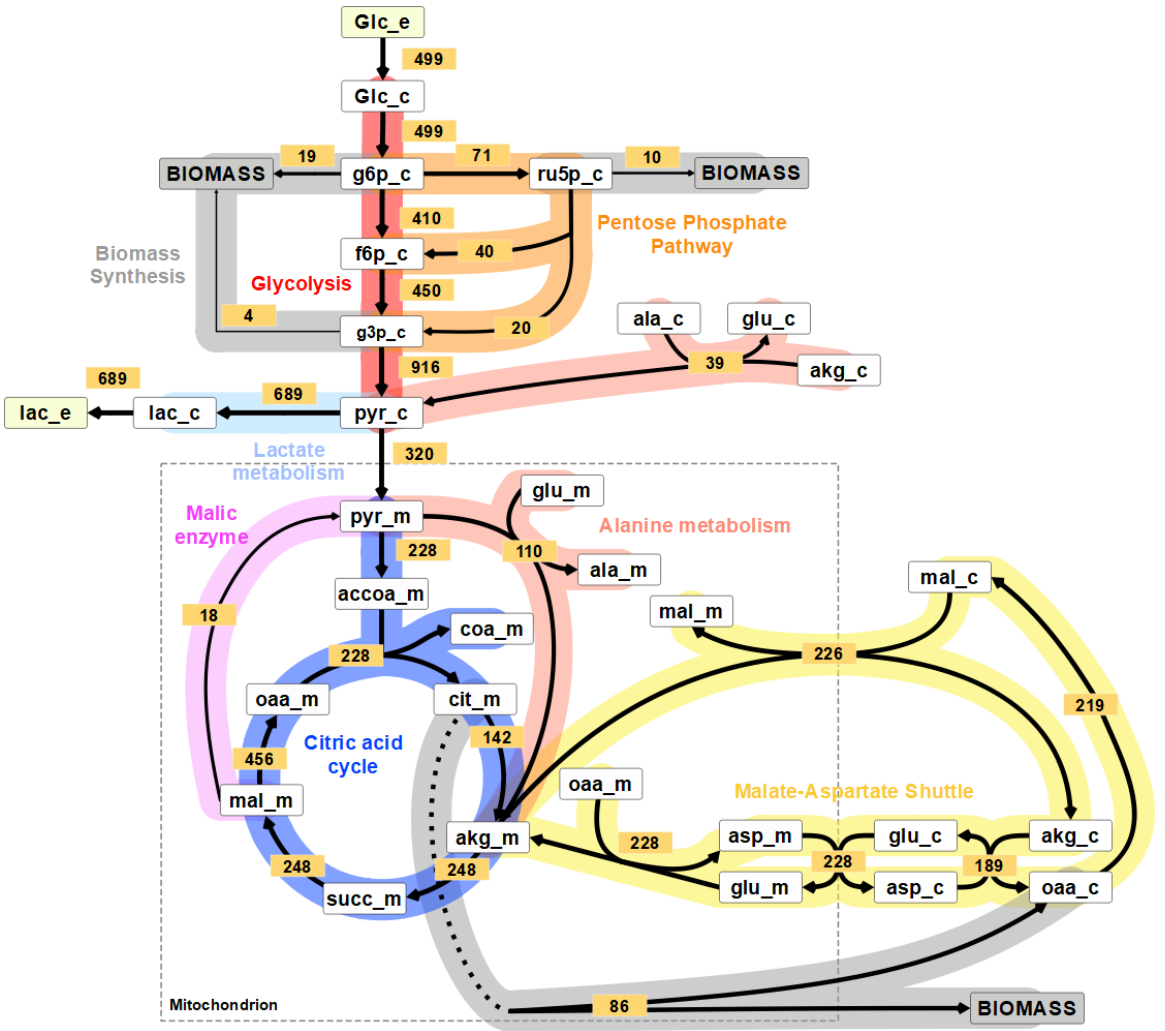
Figure 5. Metabolic flux distribution of the engineered hybridoma cell line KB26.5-BHRF1. The arrows indicate the direction of the reaction; the arrow thickness is proportional to the flux rate. Different coloring was used for each pathway, and the model was structured in cytoplasmic and mitochondrial reactions (mitochondrion is limited by a discontinued line). The values in the boxes correspond to the flux rate in nmol metabolite/mg DCW·h.